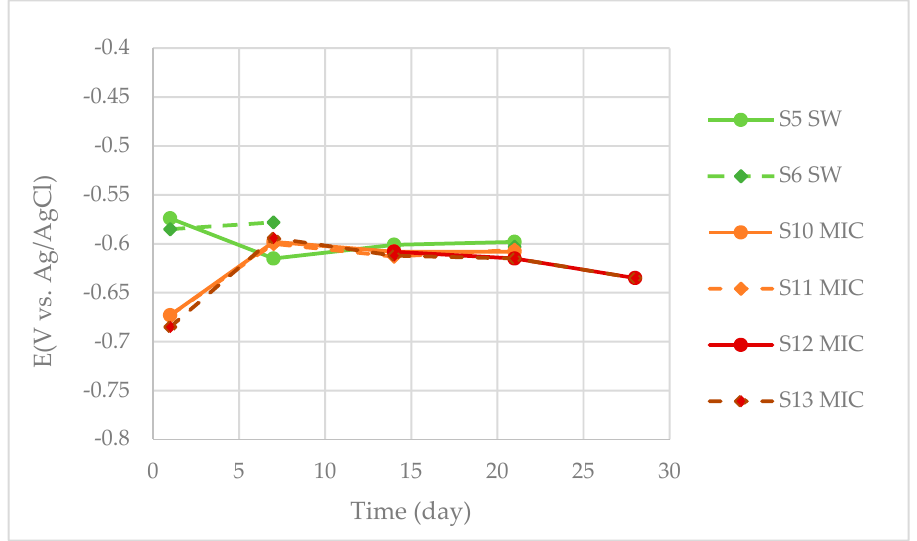
Figure 3. Open circuit potential (OCP) values as a function of time measured for R4 steel samples in seawater with and without bacteria.